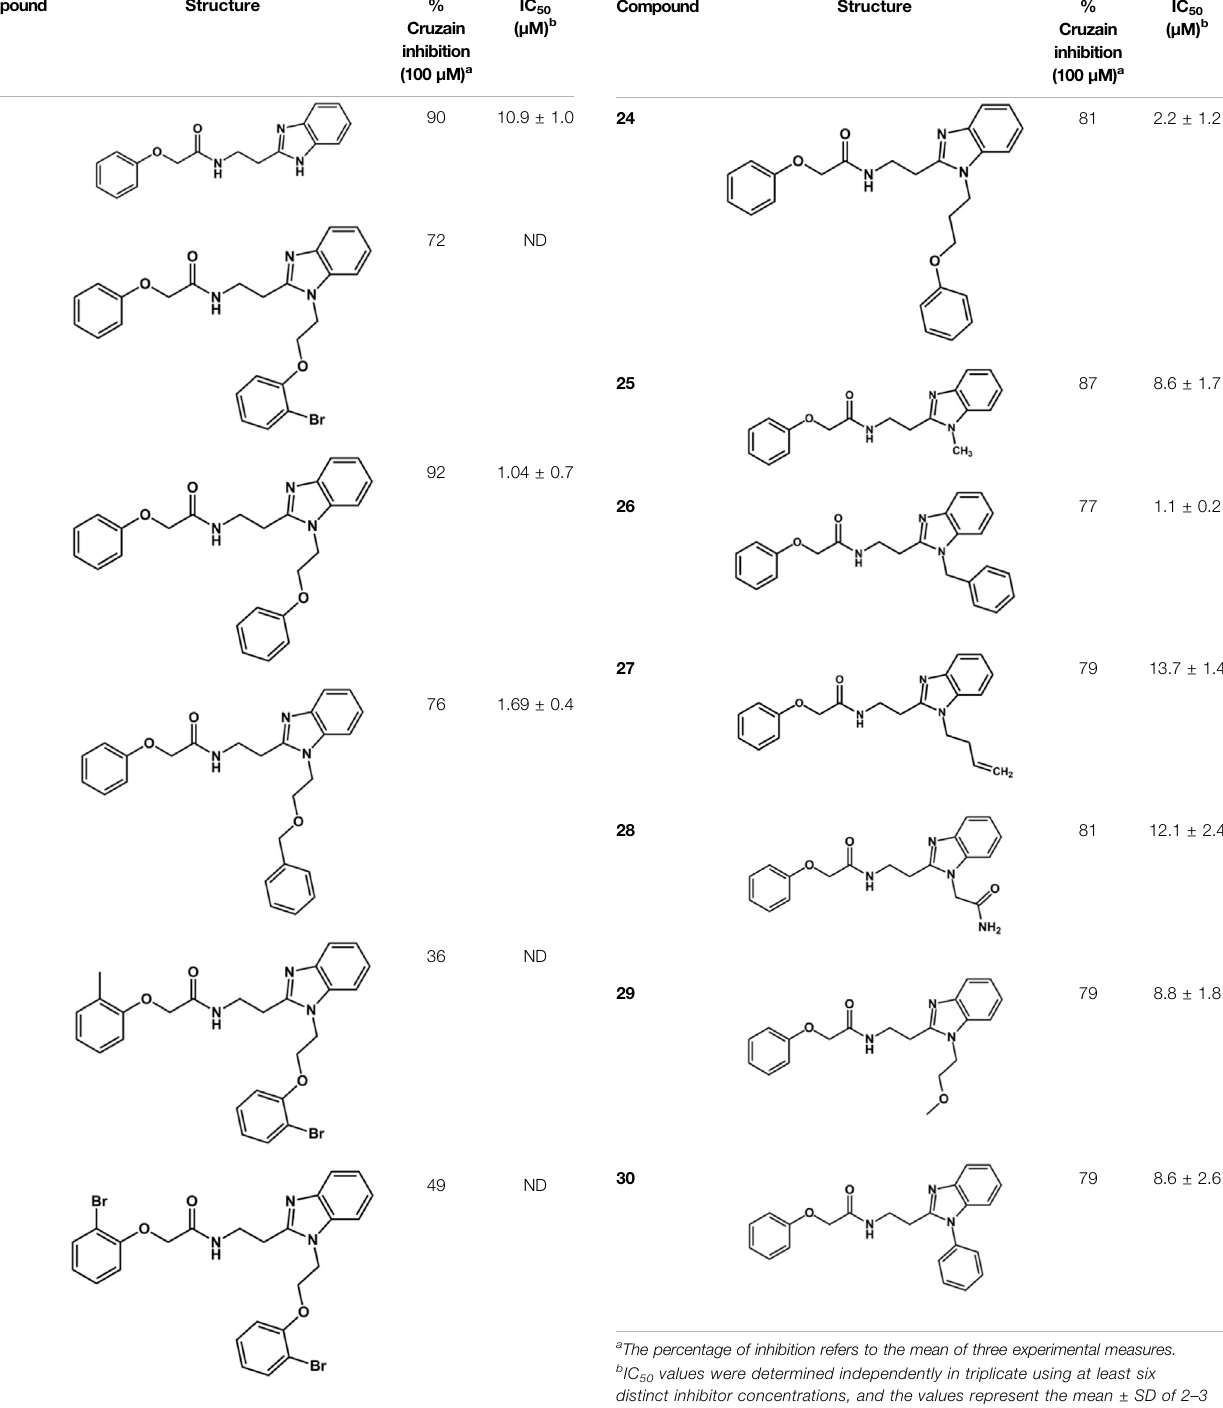
TABLE 1 | Structure and activity against cruzain of new N -substituted benzimidazole derivatives. a Compound